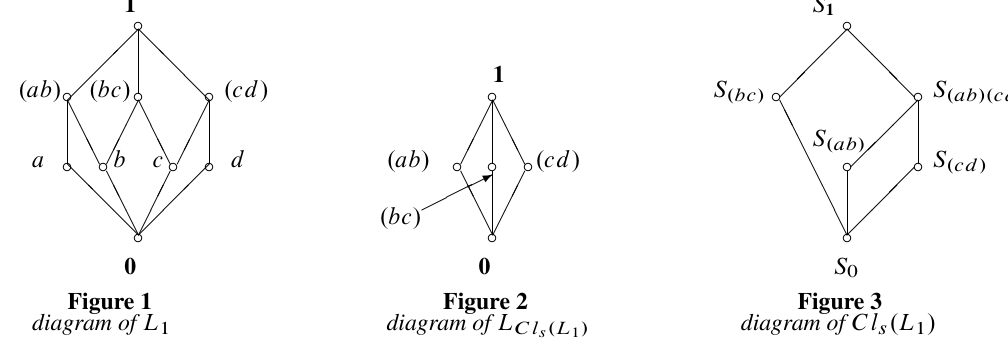
Figure 1 diagram of L 1